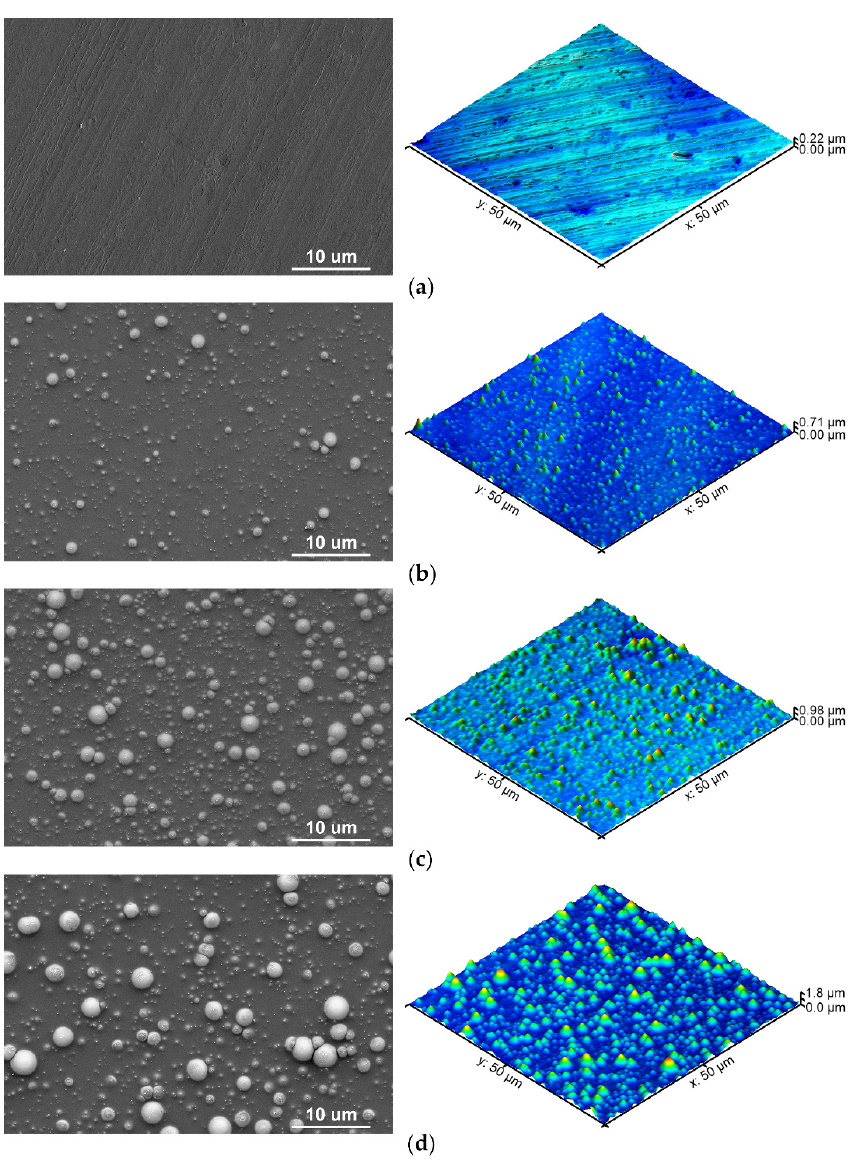
Figure 1. SEM images compared with the AFM topographies of ( a ) PEEK pristine, ( b ) PEEK treated with 100 EUV pulses, ( c ) PEEK treated with 150 EUV pulses, and ( d ) PEEK treated with 200 EUV pulses.